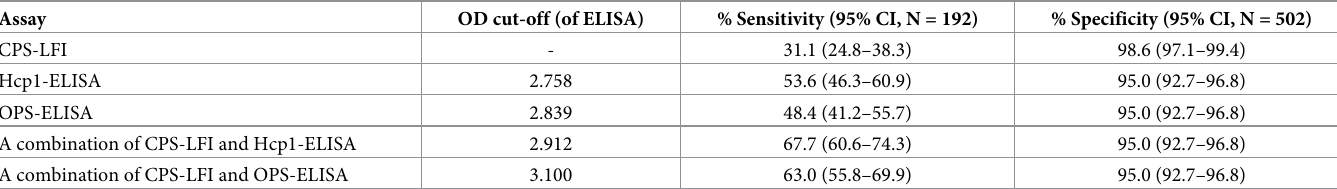
Table 1. Sensitivity and specificity of the CPS-LFI, Hcp1-ELISA, OPS-ELISA and the combinations of the CPS-LFI and Hcp1-ELISA or OPS-ELISA.